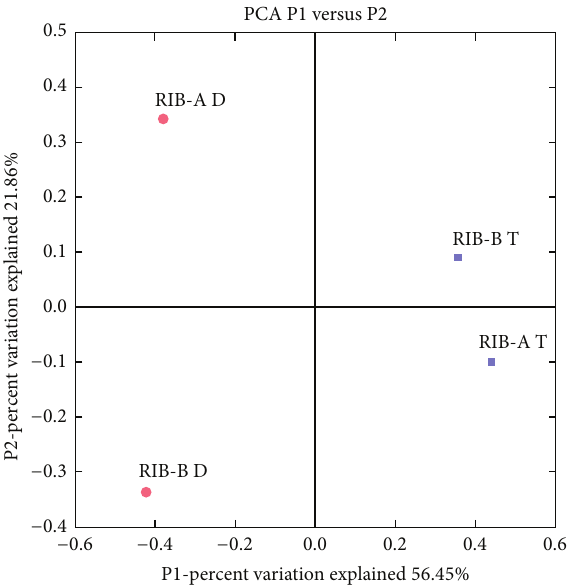
Figure 2: Unifrac principal coordinates analysis of Cerrado fresh- water lake sediments archaeal 16S rRNA gene sequences obtained in the dry season (RIB-A D and RIB-B D) and transition between dry and rainy season (RIB-A T and RIB-B T).